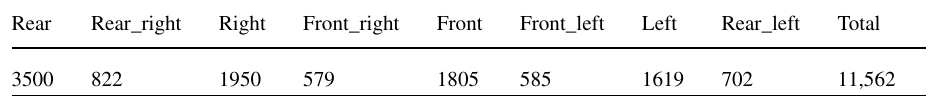
Table 2 Number of images in each class of the original PDC